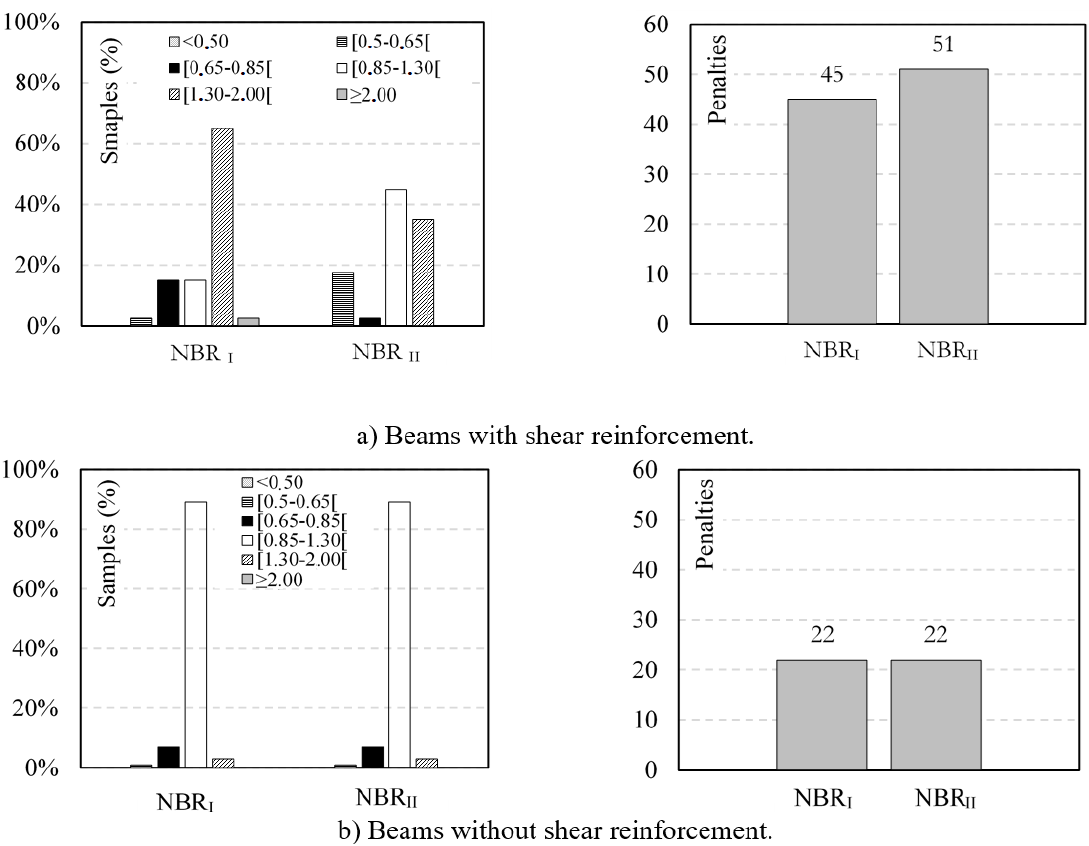
Figure 10. Result of the DPC for the beams within the